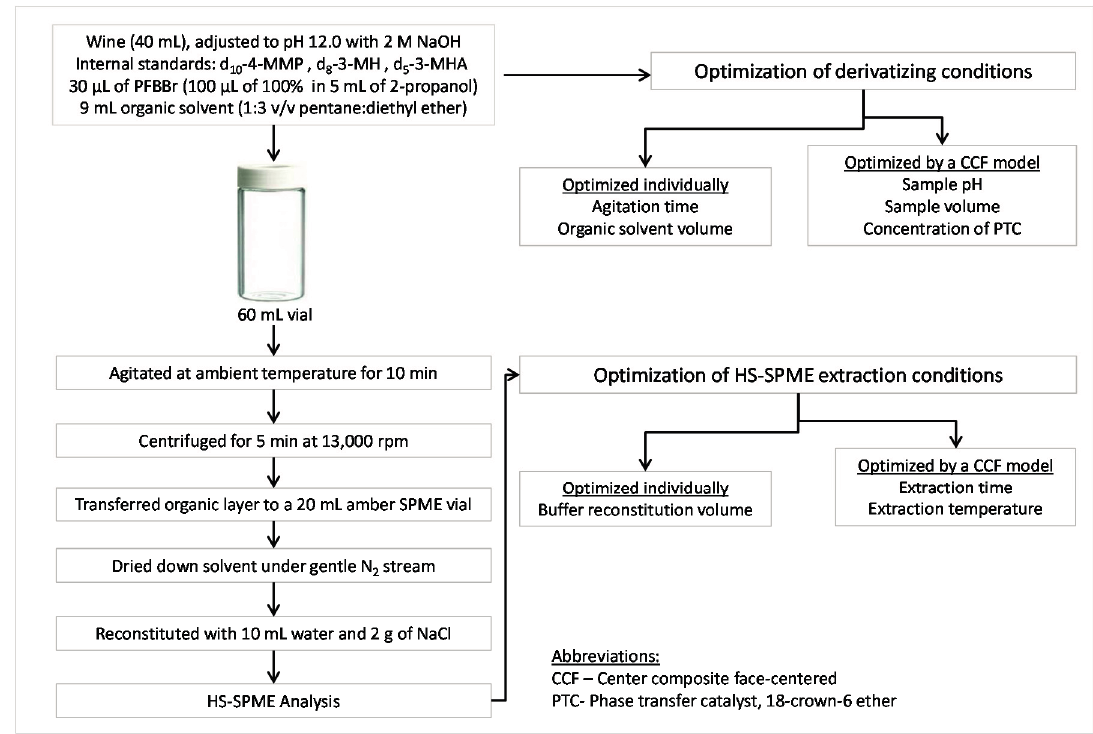
Figure A1. Schematic overview of thiol extraction and quantification, including optimization steps.